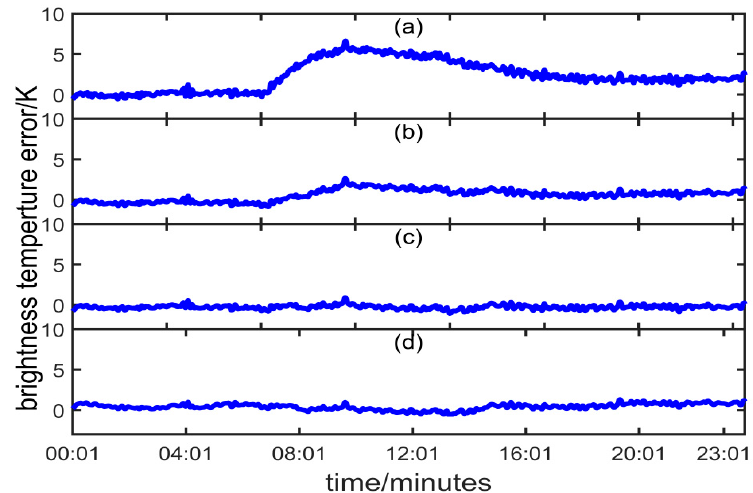
Figure 10. Calibration results of the measured data on 4 March 2017. ( a ) shows the measurement error without calibration, ( b ) shows the measurement error after system absolute calibration, ( c ) shows the measurement error after receiver gain error calibration, and ( d ) shows the measurement error after calibration of the temperature noise error of the antenna feeder system.